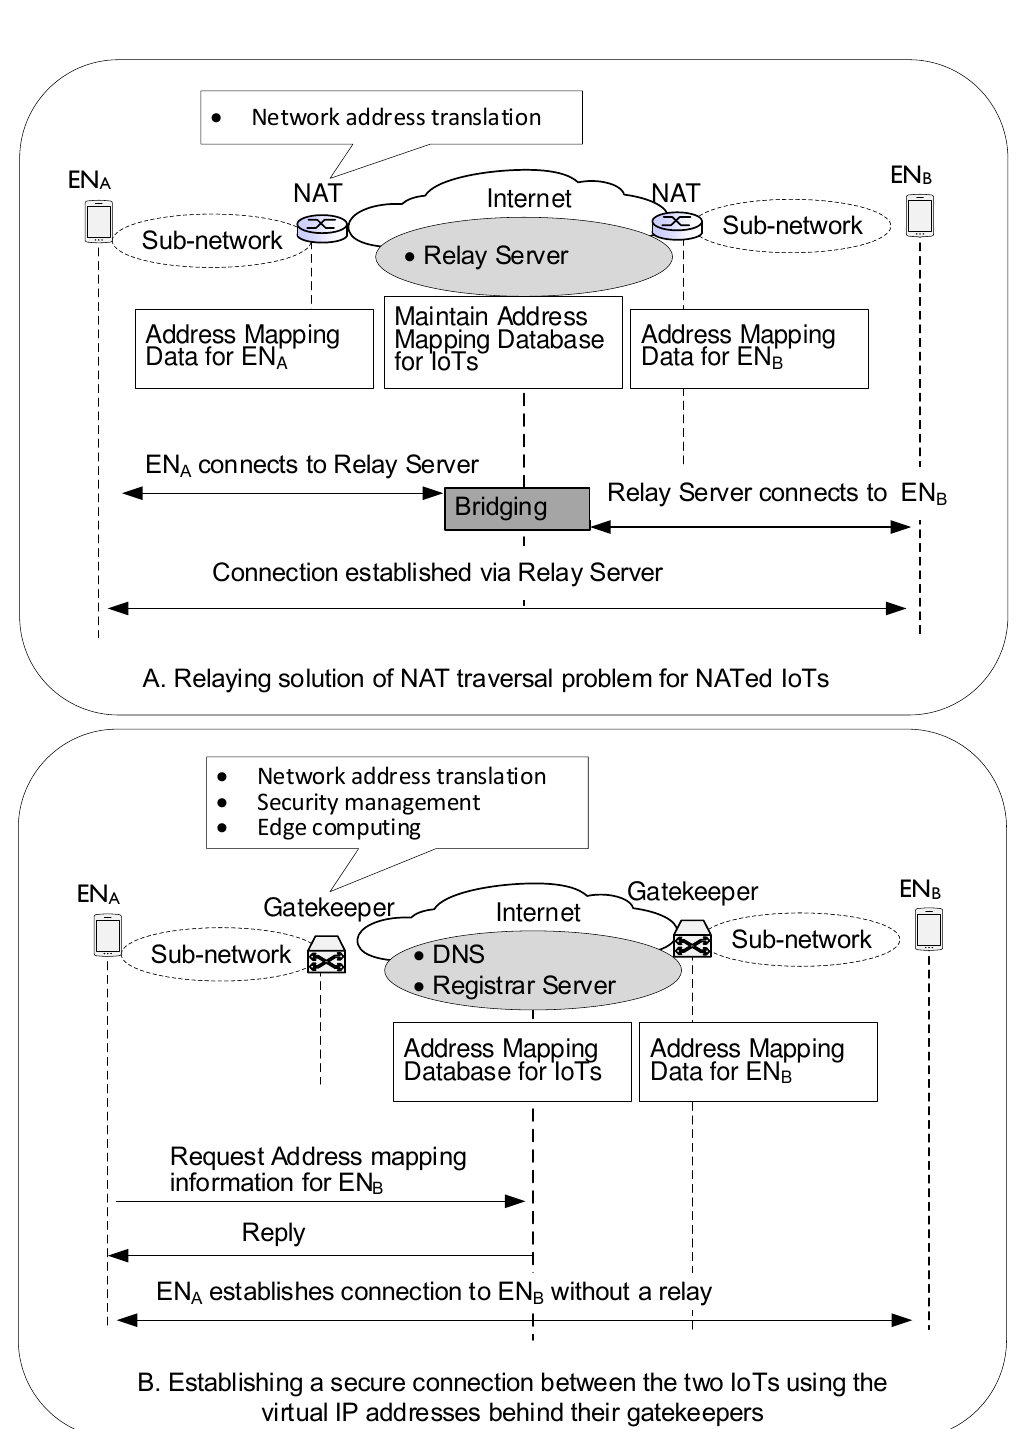
Figure 1. Comparison of NAT and Gatekeeper approaches that use invisible IP addresses from the